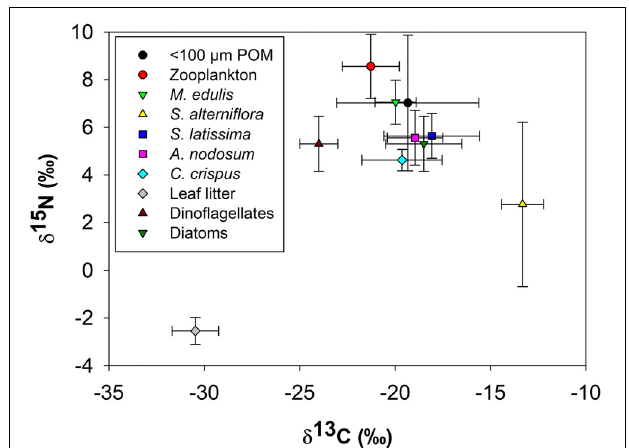
endmembers ( < 100 µ m POM, zooplankton, Spartina alterniflora , Saccharina latissima , Ascophyllum nodosum , Chondrus crispus , leaf litter, dinoflagellates and diatoms), prior to consolidation, used in the stable isotope mixing model. Data shown are average ± 1 standard deviation of endmember δ 13 C and δ 15 N.